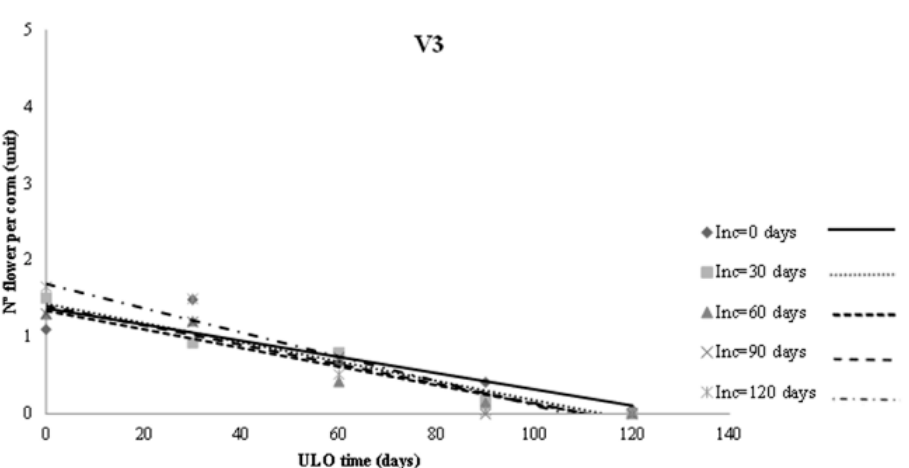
Figure 2. Graph of the number of flowers per corm (unit) for different incubation times during the ULO storage, for the different vegetative stages studied (V3–20 d and V3).